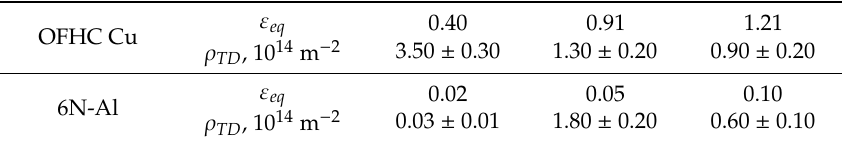
Table 2. Tangled dislocation density, ρ TD , calculated by quantitative TEM analysis at the di ff erent HPT strain levels for OFHC Cu and 6N-Al.